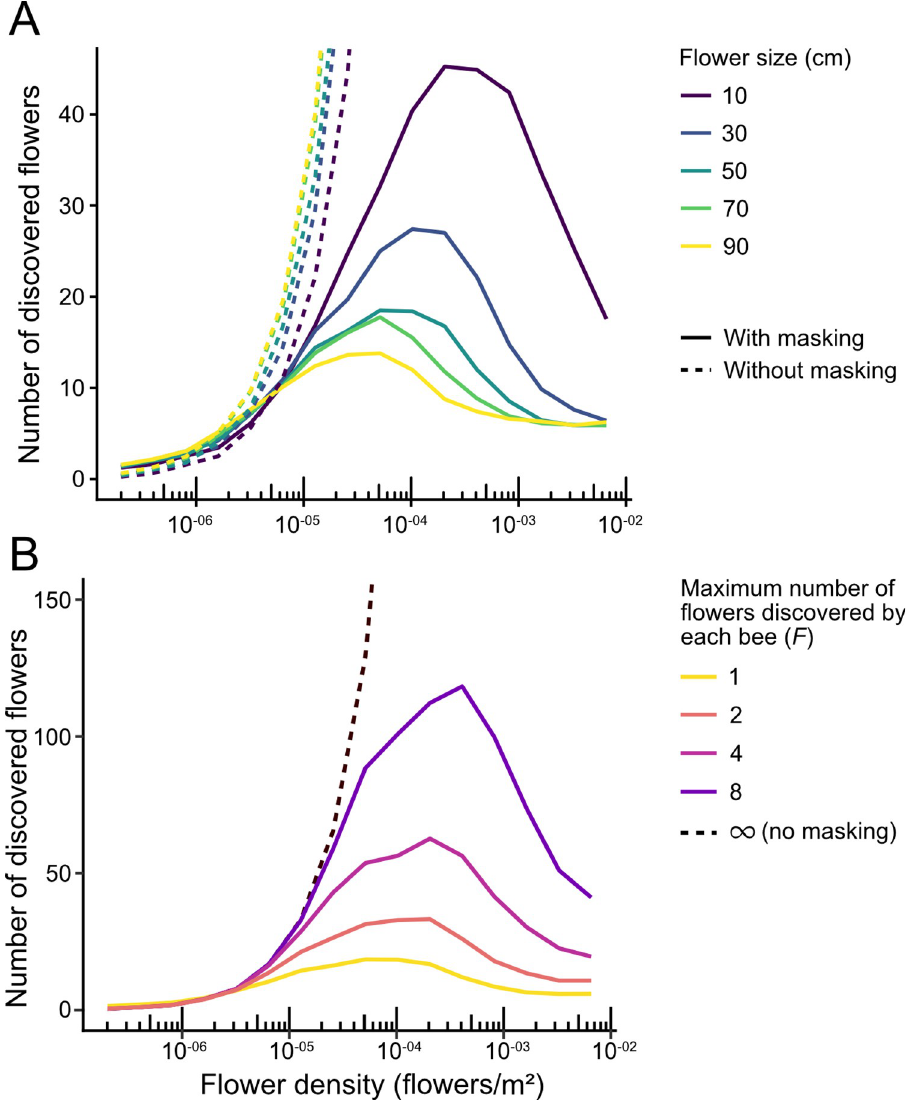
Fig 5. Number of different flowers discovered by a group of bees as a function of flower density. (A) Number of different flowers discovered in 100 exploration trips of 900 s, in an environment with randomly distributed flowers. Results are averaged over 80 simulations, keeping the environment stable for every simulation. Solid lines: Number calculated taking into account the masking effect (i.e., only counting the first flower that was discovered in each trip). Dotted lines: Results without taking into account the masking effect. (B) Same as A but for a given flower size (50 cm), and assuming that each bee will return to the nest only after having discovered a number of flowers ( F ) (note that box A corresponds to F = 1 for the simulations with masking effect, and F = 1 for the simulations without masking effect). Line colors represent the maximum number of flowers discovered by each bee ( F ).